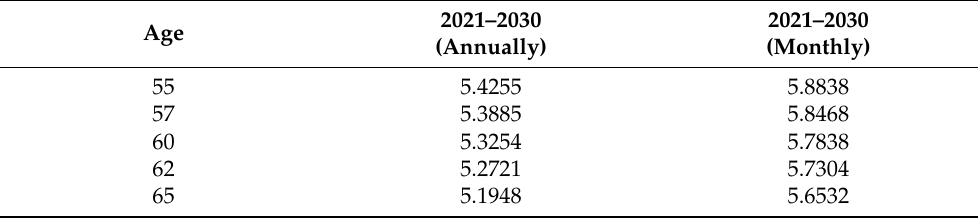
Table 8. Projected Annuity Factor Cost for Retirement Age—Q-CBD